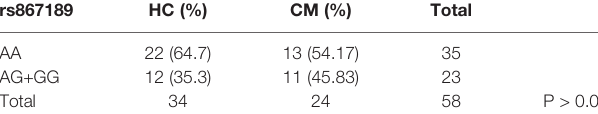
TABLE 6 | The ratio of rs867186 genotype-AA versus -AG and -GG in HC and CM. rs867189